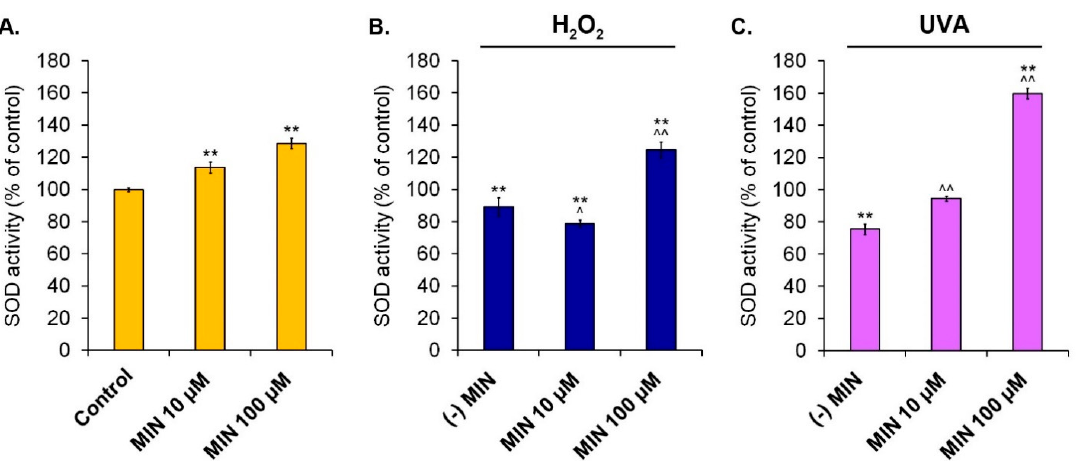
Figure 6. Changes of superoxide dismutase activity in human normal melanocytes treated with minocycline ( A ) as well as additionally exposed to hydrogen peroxide ( B ) or irradiated with UVA ( C ). ** p < 0.005. vs. control; ^ p < 0.05, ^^ p < 0.005. vs. (-) MIN.